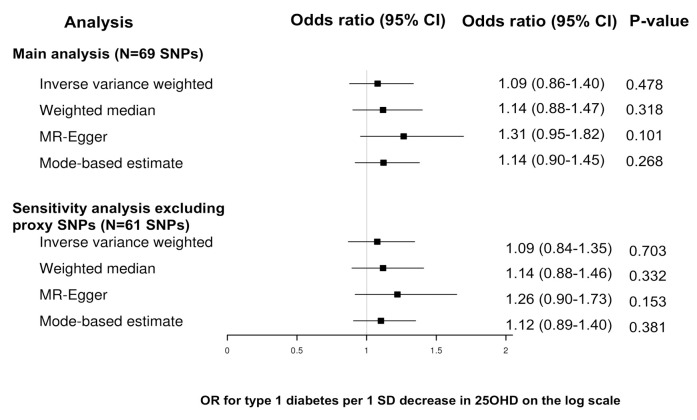
Forest plot of the MR study investigating the effect of 25OHD on type 1 diabetes.Forest plot of the main study and of the sensitivity analysis excluding proxy SNPs. 25OHD, 25-hydroxyvitamin D; MR, Mendelian randomization; SNP, single nucleotide polymorphism.